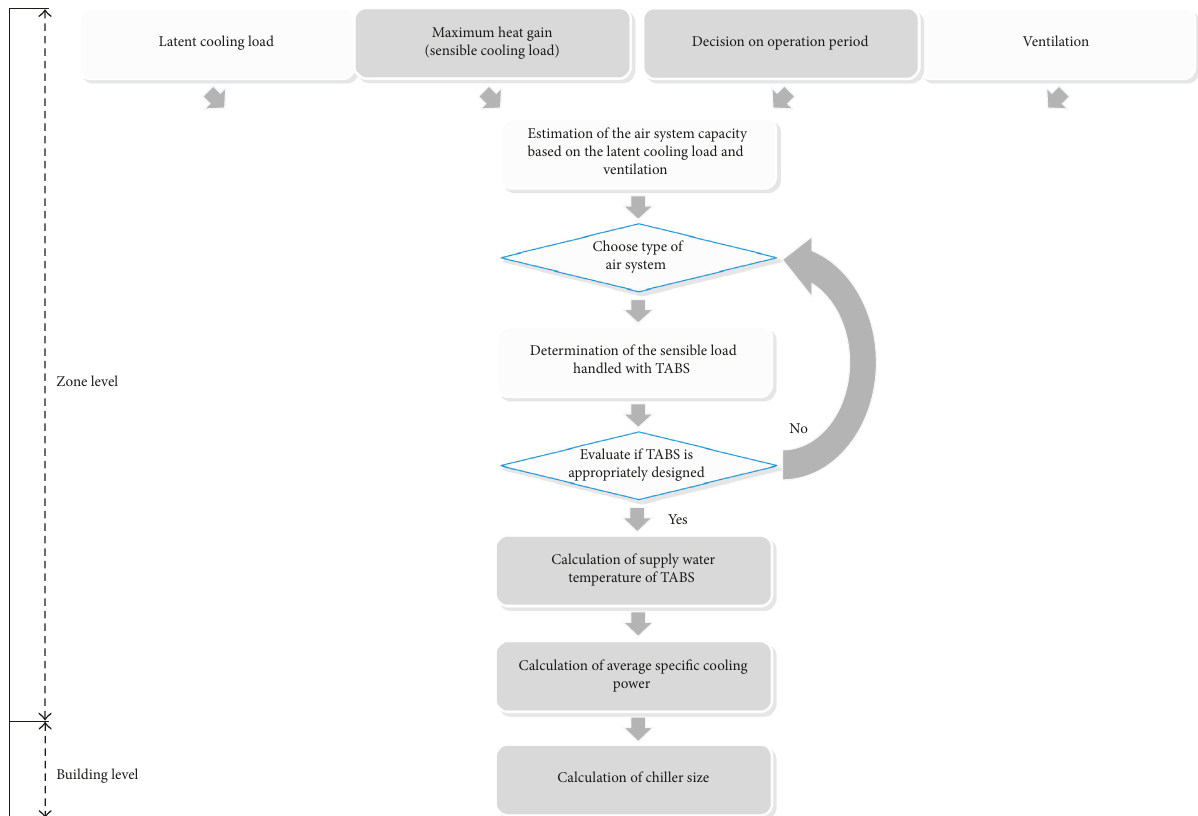
Figure 4: Schematics of the proposed design